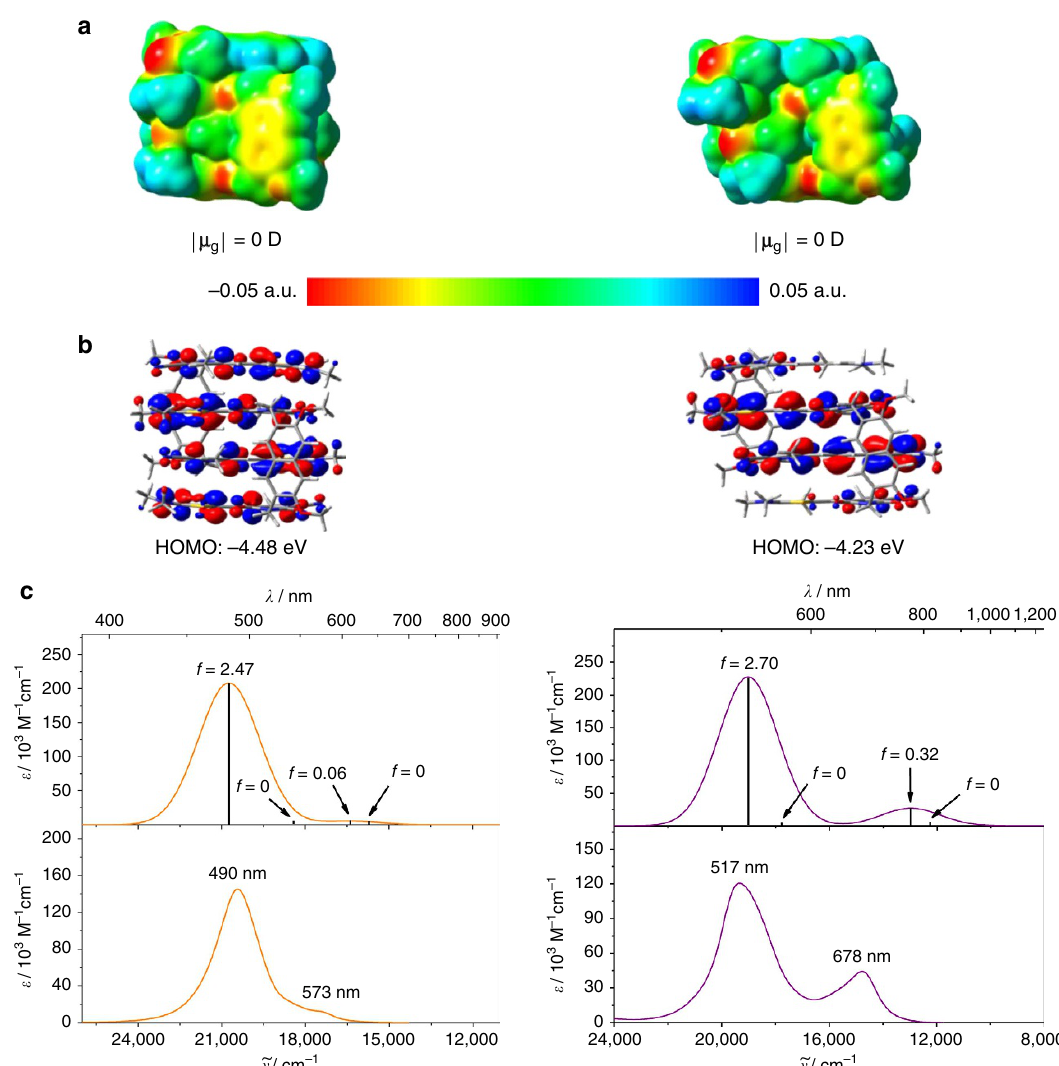
Figure 5 | Quantum chemical calculation studies. ( a ) Electrostatic potential surface (isovalue ¼ 0.001 a.u.) and ( b ) HOMO distribution (isovalue ¼ 0.02 a.u.) of the geometry-optimized structures (B97D3, def2-SVP) of the dimers of bis(merocyanine) dye 1 (left) and 2 (right). ( c ) time-dependent DFT ( o B97/def2-SVP) calculated (top) and experimental dimer spectra (bottom) of bis(merocyanine) 1 (left) and 2 (right). The calculated spectra were shifted by 0.6eV towards lower energies. The experimental dimer spectra were calculated from the data obtained by concentration-dependent UV/vis studies in